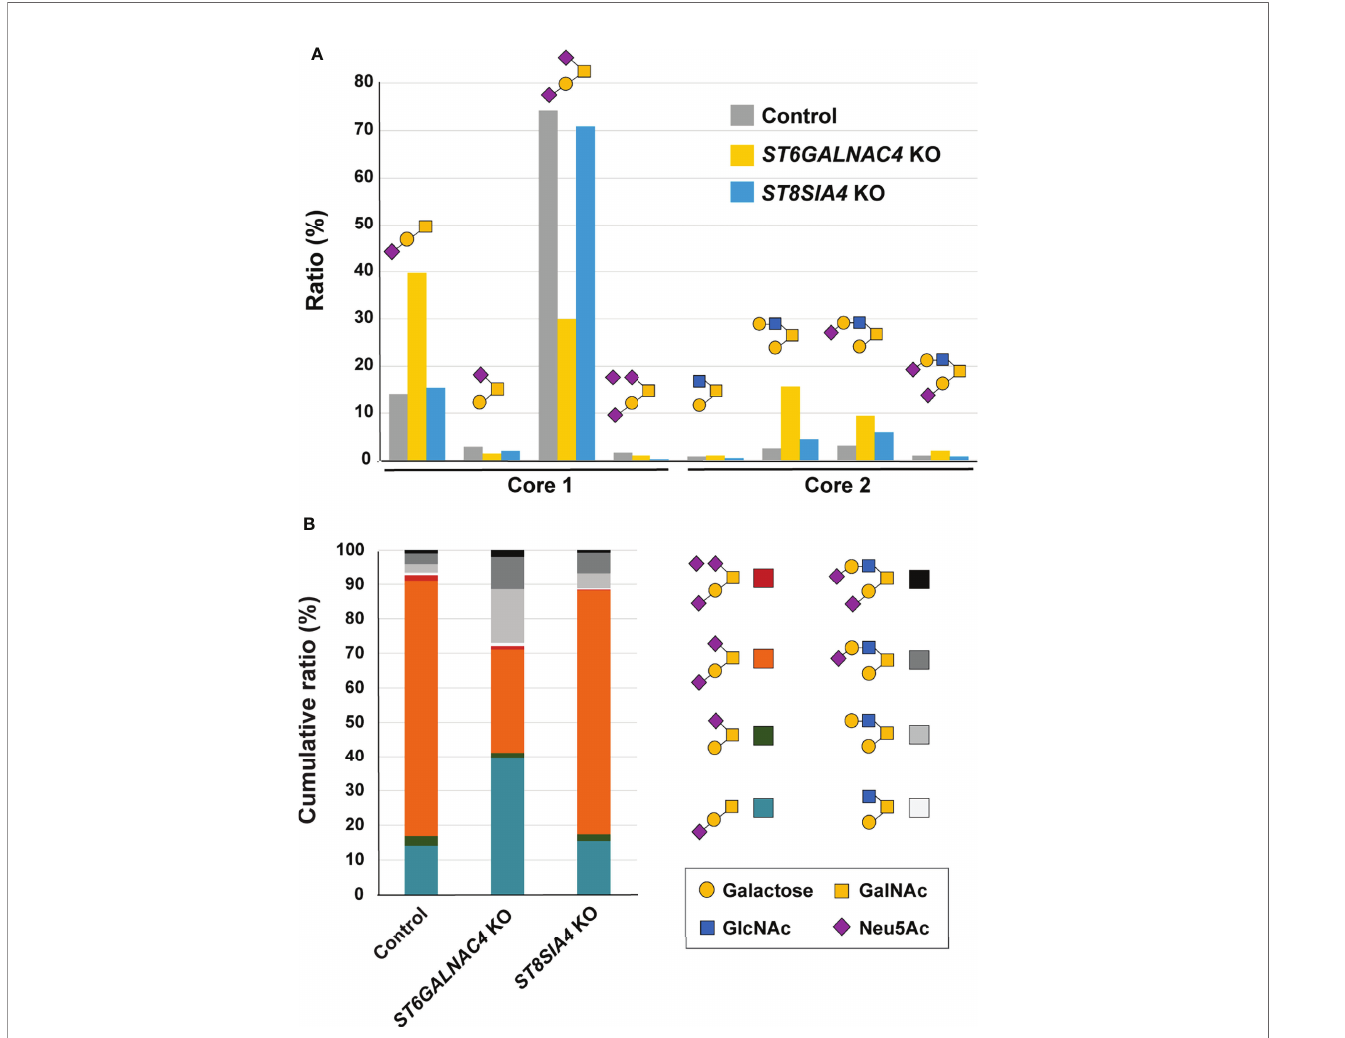
FIGURE 5 | ST6GalNAc-IV is responsible for the biosynthesis of disialyl-T in JVM-3 cells. (A) O-glycans were released by reductive elimination from control (gray), ST6GALNAC4 KO (yellow), and ST8SIA4 KO (blue) JVM-3 cells; permethylated; and subjected to liquid chromatography with tandem mass spectrometry analysis. Except for monosialyl-T (Neu5Ac a 2 – 3Gal b 1 – 3GalNAc a 1 – or Gal b 1 – 3[Neu5Ac a 2 – 6]GalNAc a 1 – ), which could be resolved by liquid chromatography into two distinct isomeric structures, and trisialyl-T, which consisted of two unresolved positional isomers (Neu5Ac a 2 – 3Gal b 1 – 3[Neu5Ac a 2 – 8Neu5Ac a 2 – 6] GalNAc a 1 – and Neu5Ac a 2 – 8Neu5Ac a 2 – 3Gal b 1 – 3[Neu5Ac a 2 – 6]GalNAc a 1 – ), each of the other O-glycans was found to be represented by a single dominating structure, as determined by tandem mass spectrometry and annotated accordingly using the Symbol Nomenclature for Glycans (52). Relative abundance was calculated from the peak areas of extracted ion chromatograms and normalized to the percentage total. Disruption of ST6GALNAC4 resulted in a reduction in the disialyl-T (Neu5Ac a 2 – 3Gal b 1 – 3[Neu5Ac a 2 – 6]GalNAc a 1 – ) structure and a concomitant increase in the monosialyl-T (Neu5Ac a 2 – 3Gal b 1 – 3GalNAc a 1 – ) and core 2 (e.g., Gal b 1 – 3[Gal b 1 – 3GlcNAc b 1 – 6]GalNAc a 1 – ) structures. Disruption of ST8SIA4 resulted in the loss of the trisialyl-T structure. (B) Stacked bar chart of the same data shown in panel (A) , along with the color code used for each of the eight major O-glycans identi fi ed and quanti fi